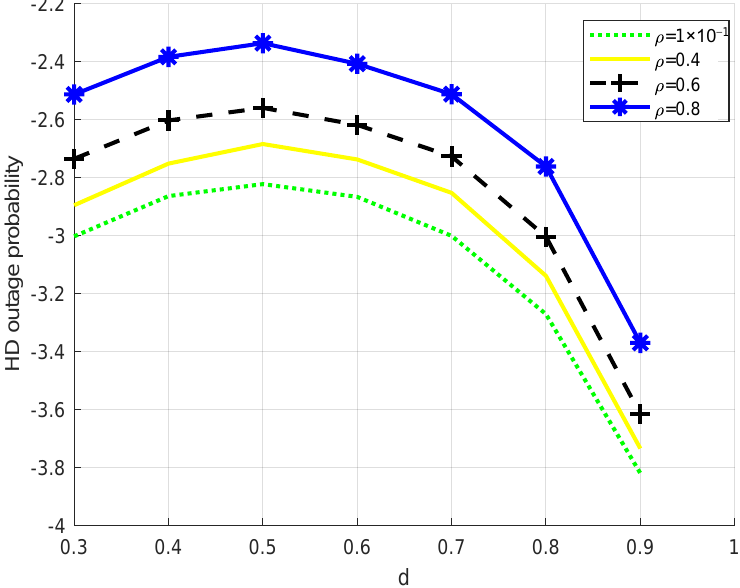
Figure 9. Half-duplex outage probability comparison with different distances. Then, the remaining interference | h r | 2 changes from − 85 db to − 15 db, and the source transmit power is 1 db. We obtain the capacity in the full-duplex system. As shown in Figure 10, we found that | h r | 2 is smaller than − 40 db, and the capacity stays the same. When | h r | 2 increases, the capacity monotonically decreases. The interference affects the SNR of the system, and the system performance degrades. When the PS factor is small, more energy is harvested and more capacity is